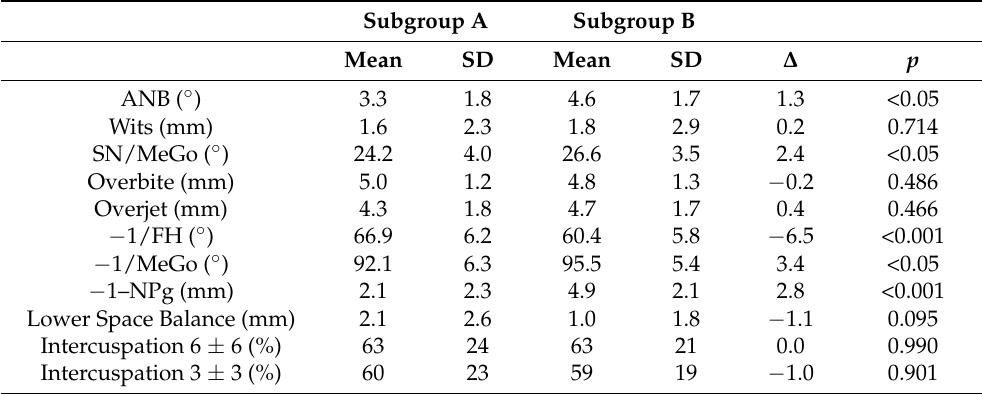
Table 6. Comparison of descriptive parameters at T1 of Subgroups A ( N = 61; selection parameters at T2: − 1/FH ≥ 58 ◦ and − 1/NPg ≤ 5.5 mm) and B ( N = 18; selection parameters at T2: − 1/FH ≤ 52 ◦ and − 1/NPg ≥ 6 mm) of patients from NonEx LT group.